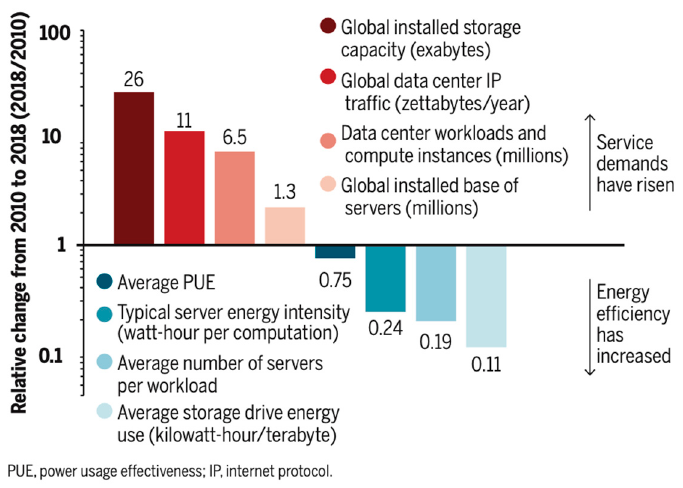
Figure 3. Trends in global data center energy-use. Reprinted with permission from Masanet et al. (2020). The American Association for the Advancement of Science.